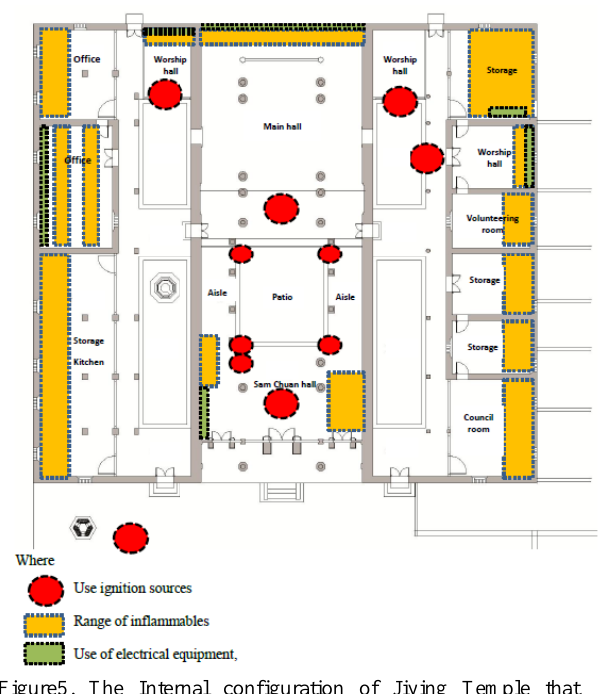
Figure5. The Internal configuration of Jiying Temple that indicated the ignitions and combustibles.